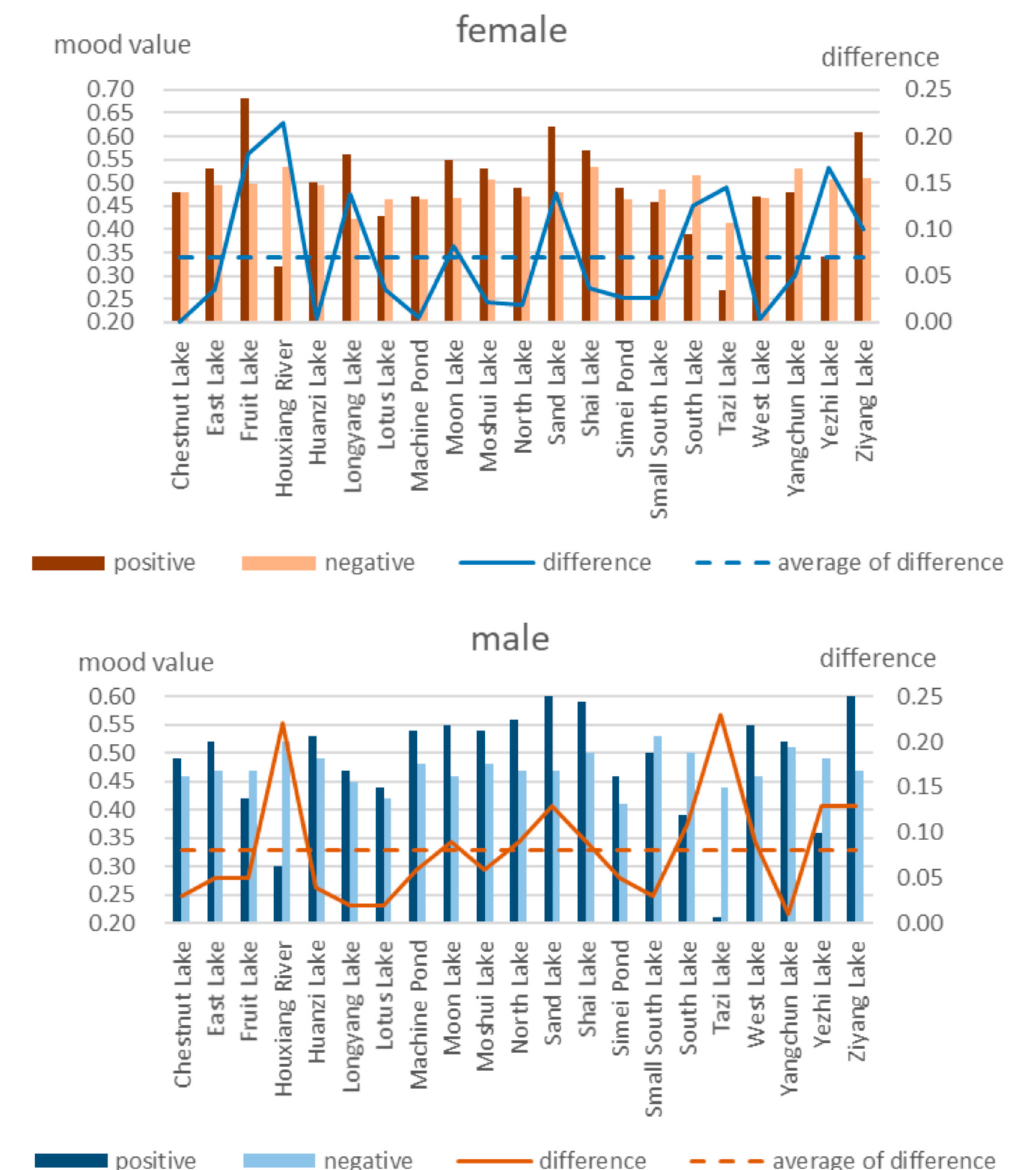
Figure 9. Comparative analysis of positive and negative emotions.